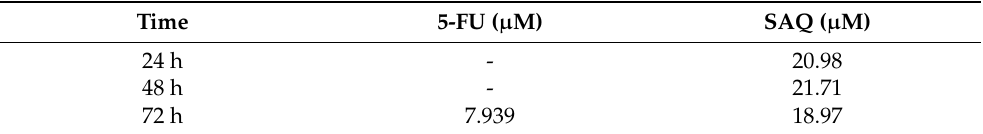
Table 1. Values of IC 50 obtained after exposure of PC-3 cells to 5-FU and SAQ for various time points.